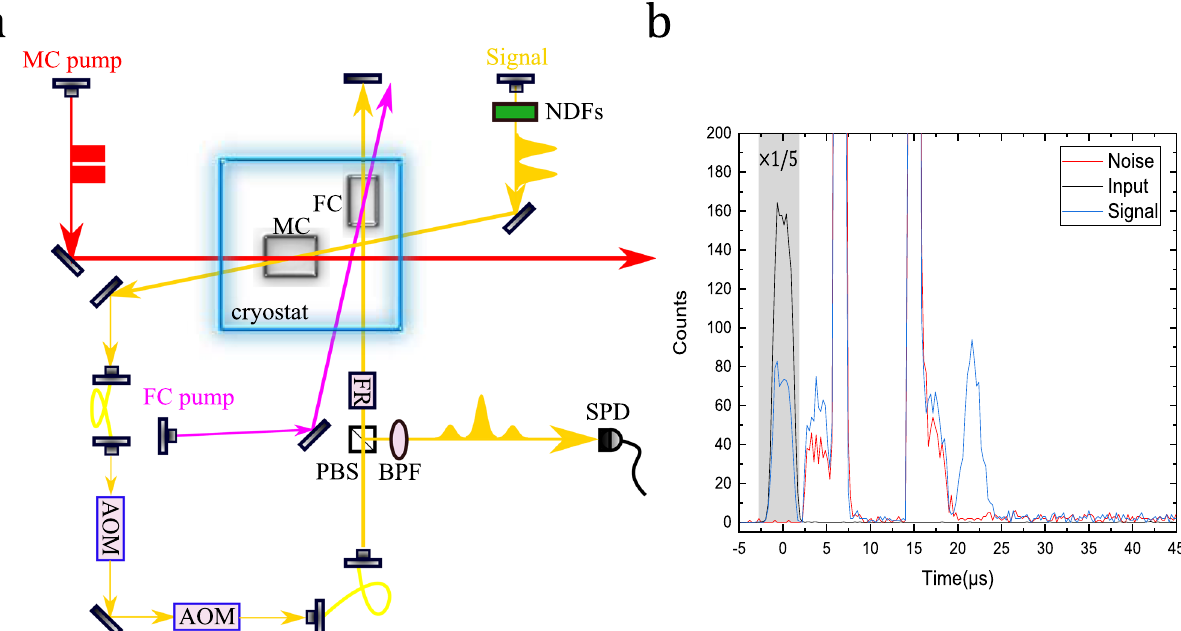
Fig. 1 Energy level diagram and experimental sequence. a Energy-level structure of 151 Eu 3 + in a Y 2 SiO 5 crystal at zero magnetic fi elds. The laser is resonant with 5 D 0 and 7 F 0 electronic states at 580 nm. Signal pulse (yellow) is resonant with ± 1 = 2 employed in the preparation step for isolating a single class of ions in the inhomogeneously broadened ensemble. b Experimental pulse sequence. Including the signal sequence and the pump sequence for the memory crystal (MC) and fi lter pump sequence for fi lter crystal (FC). We use f ij to denote the center frequency of light, which is resonant with the atomic transition. The preparation process includes three steps: class cleaning, spin polarization, and back pump (see the text for details). After the preparation process, the signal pulse incidents at t 0 , and control pulses π 35 , π 13 , π 13 , π 35 incident at t 1 , t 2 , t 3 , and t 4 ,